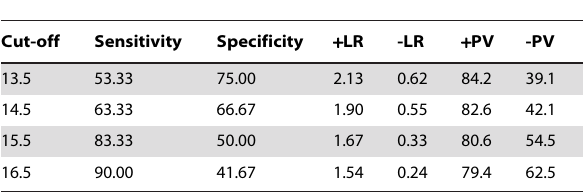
Table 5. Criterion values and coordinates of the ROC curve for the Child-Na score to predict one-year survival for different cut-off values observed in the training